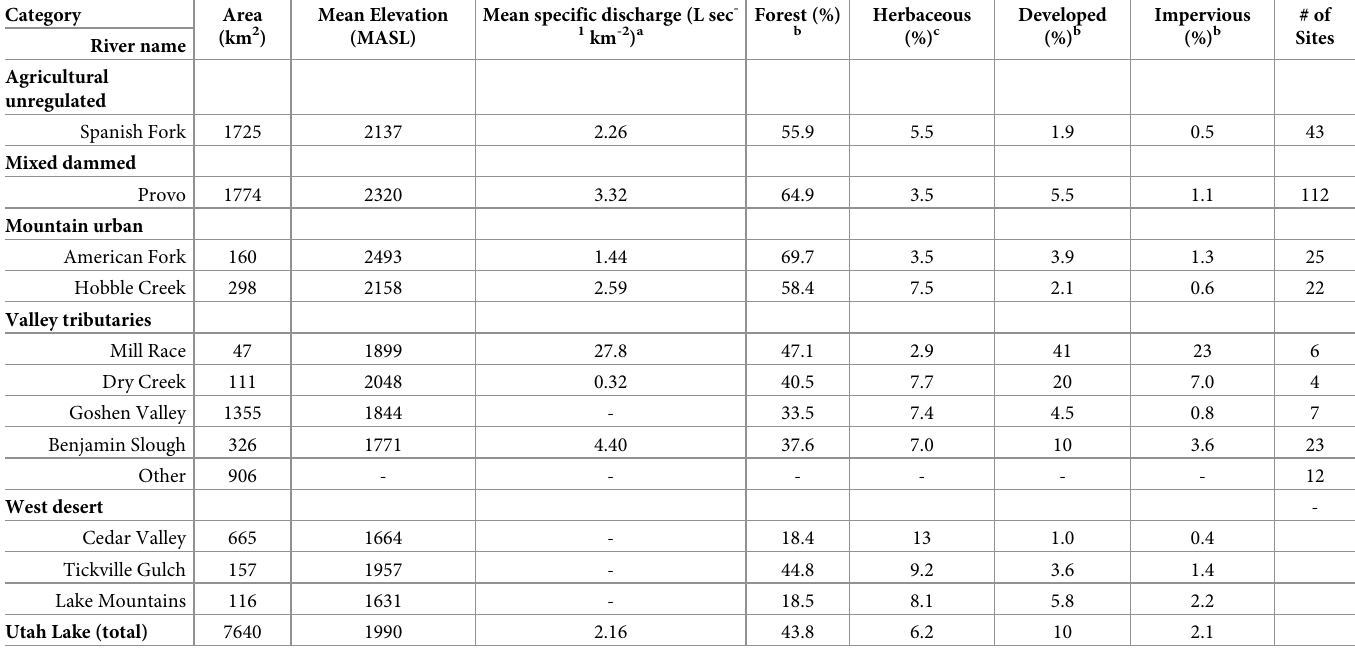
Table 1. Watershed characteristics for contributing areas to Utah Lake